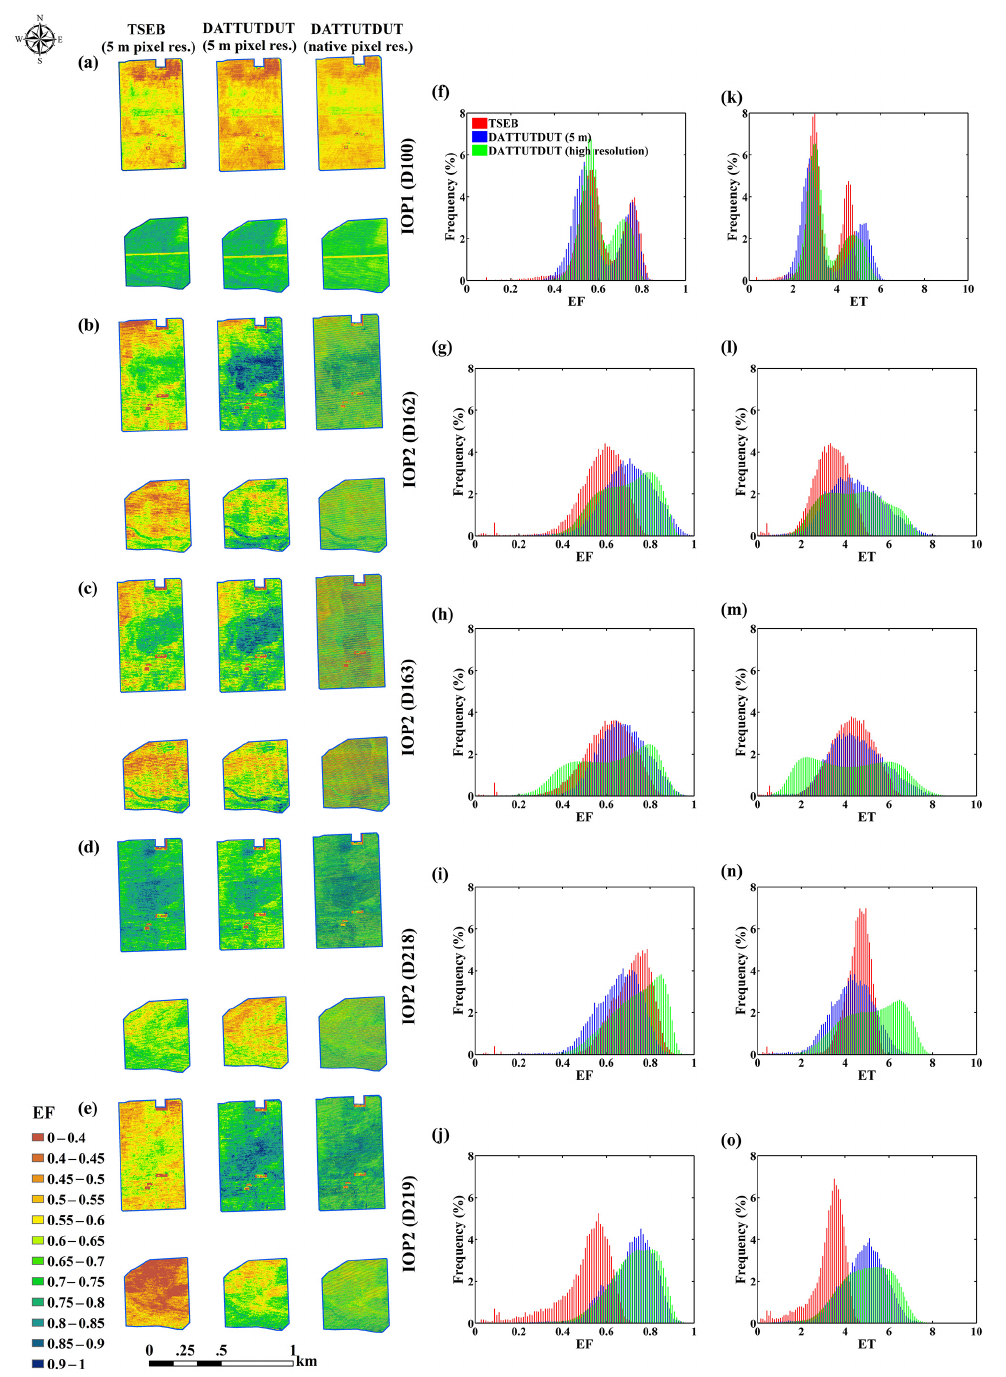
Figure 9. Comparison of TSEB (5m resolution) and DATTUTDUT model output at 5m and native pixel resolution: spatial distribution of instantaneous EF (a–e) , frequency histogram of instantaneous EF (f–j) and daytime ET (k–o) .